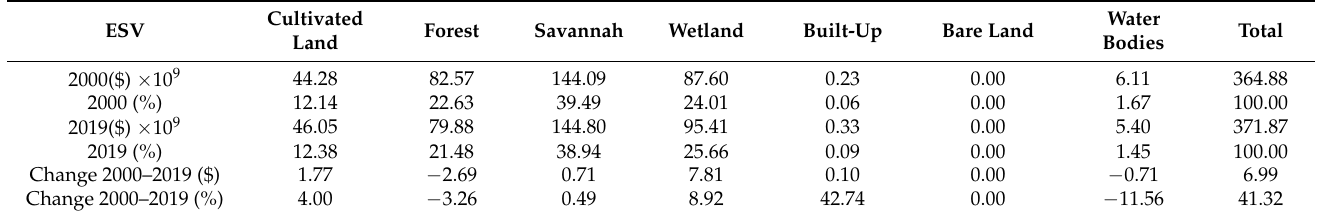
Table 6. Madagascar’s Ecosystem services value (ESV) by land-use type and changes from 2000 to